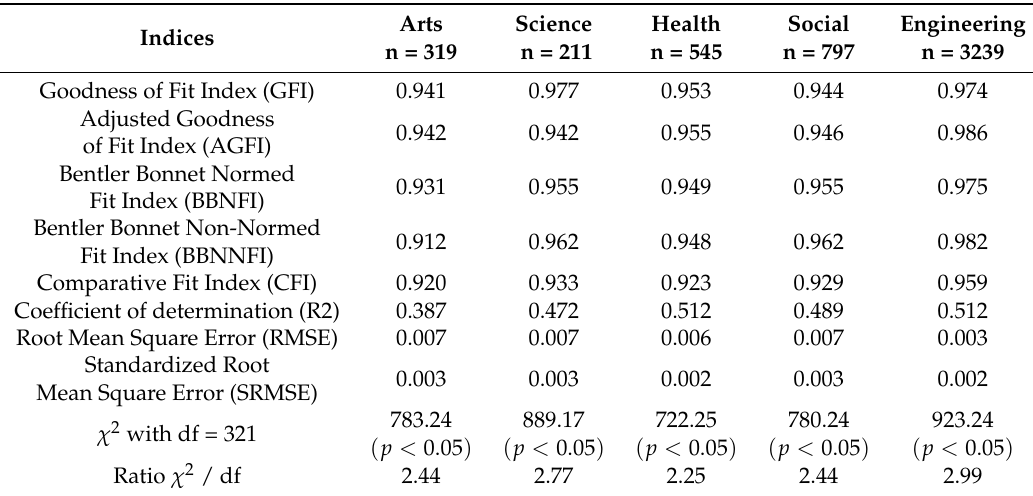
Table 1. Indices of goodness of